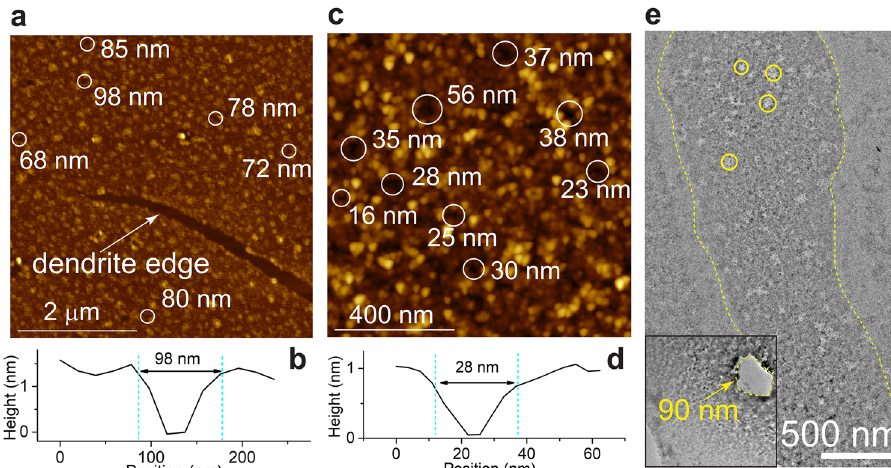
Fig. 4 Nanopores in dendritic PdSe 2 . a Atomic force microscopy image showing the nanopores with pore diameters in the range 68 – 98 nm in 2L PdSe 2 . b Line pro fi le showing the diameter of 98 nm for a nanopore. c White circles enclosed nanopores with an average diameter ranging from 16 – 56 nm in 2L PdSe 2 . d Line pro fi le measures the diameter of 28 nm of a nanopore. e Bright fi eld low-resolution TEM image of 2L PdSe 2 with nanopores (yellow circled), and the inset re fl ects nanopores with an average diameter of 90